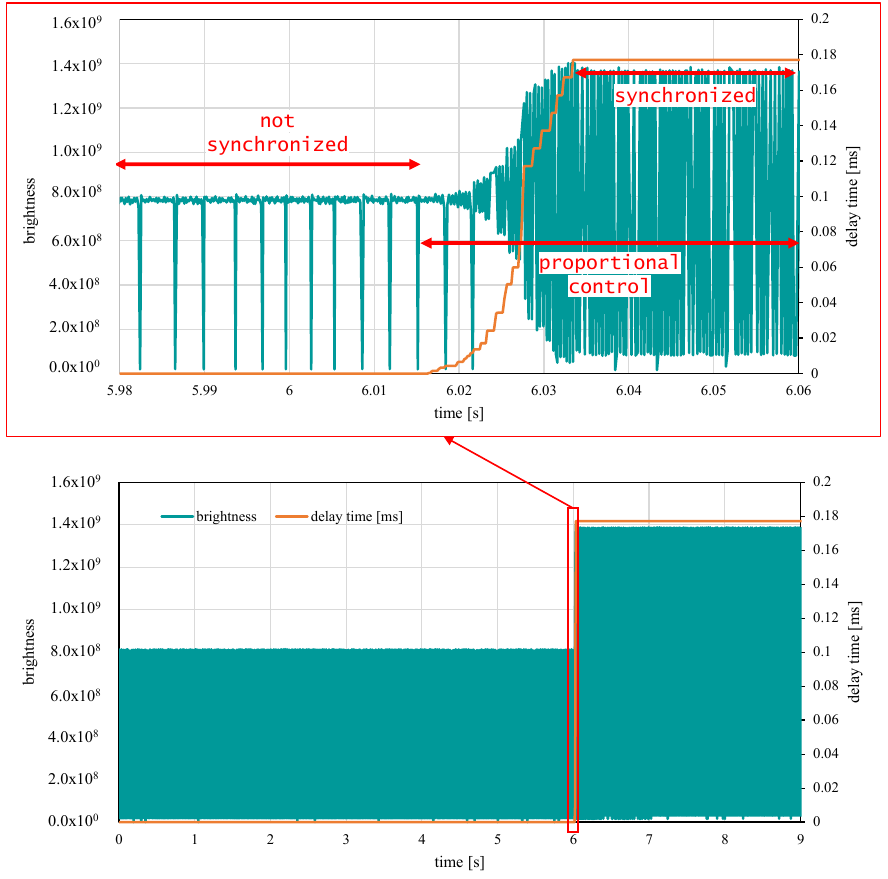
Figure 7. Relationship between total brightness and delay during alternative black-and-white projection at 3000